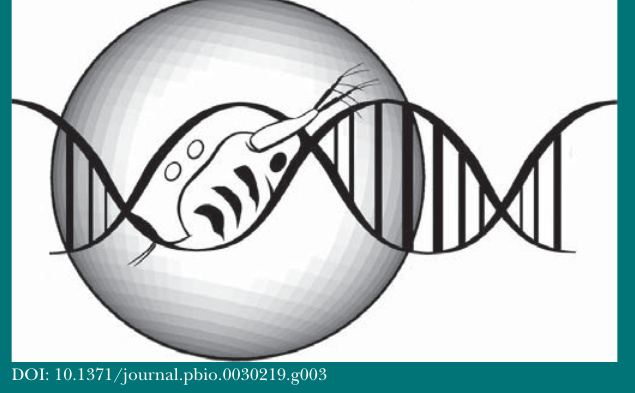
Figure 3. The Daphnia Genomics Consortium Logo (Design: S.